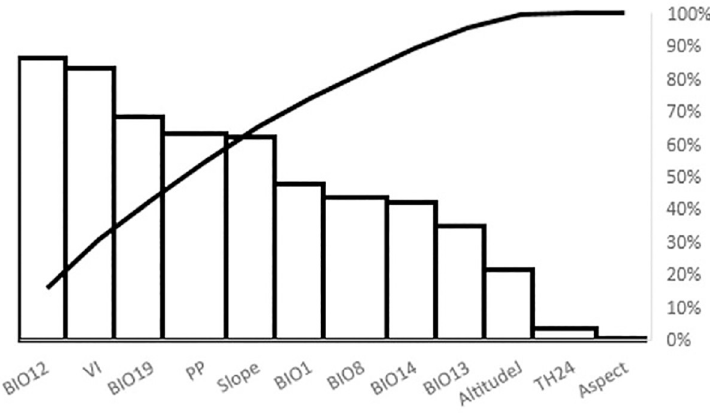
Fig 5. Percentage contribution of environmental variables to Diatraea spp.